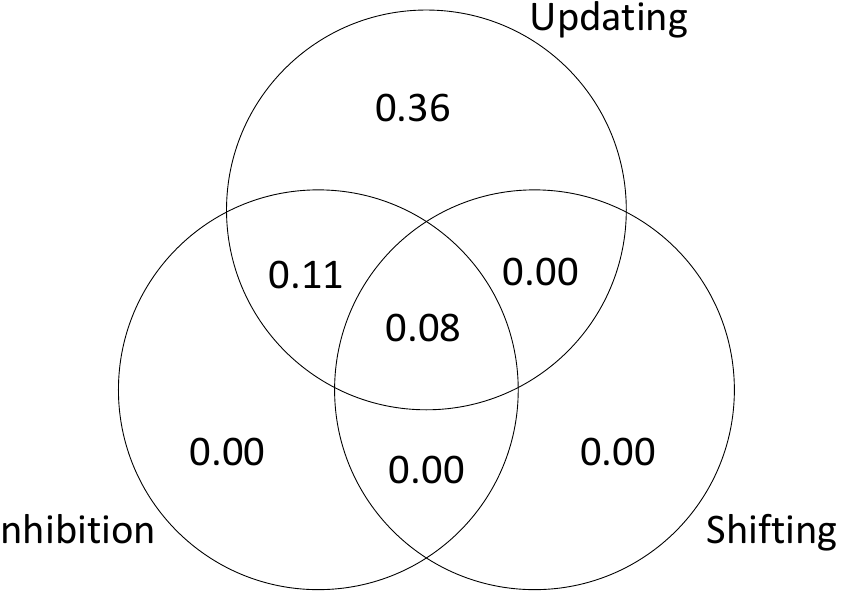
Figure 8. Unique and shared variance in g accounted for by executive functions, Benedek et al. (2014).